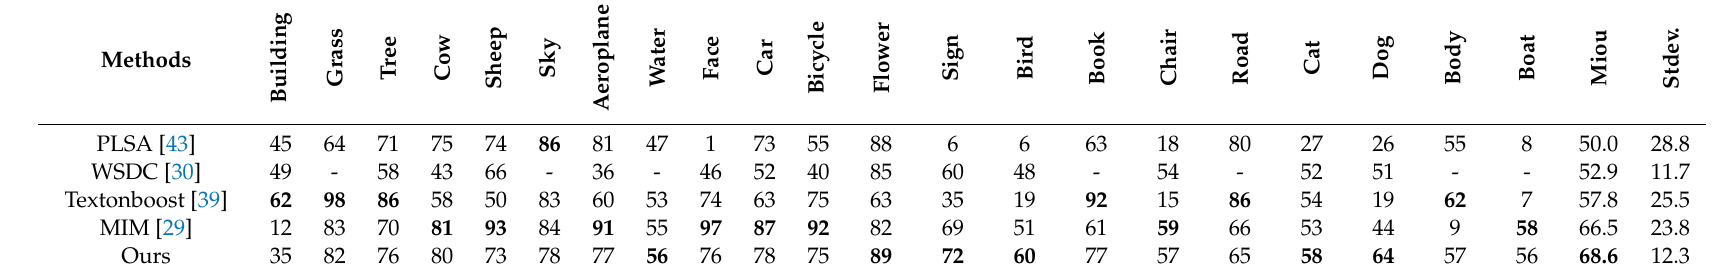
Table 2. Comparison with the state-of-the-art algorithms in term of IOU (%) on the MSRC dataset.